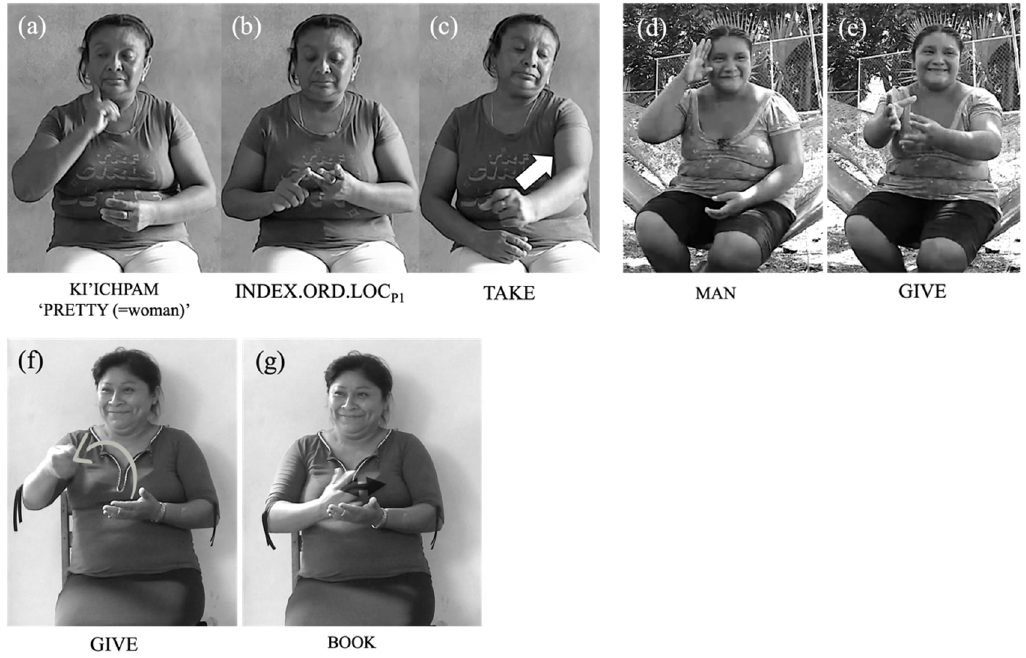
Figure 5. Examples of uninflected verbs (( a – f ) signers of 1st generation from Chicán; ( f , g ) signer of 1st generation from Trascorral) ( a – c ) “there is a woman, she is on this end, she takes”; ( d , e ) “man gives”; ( f , g ) “someone gives a book”. (Note that here TAKE is a ‘backwards verb’, moving from the direct object to the subject, see Meir (1998) for a